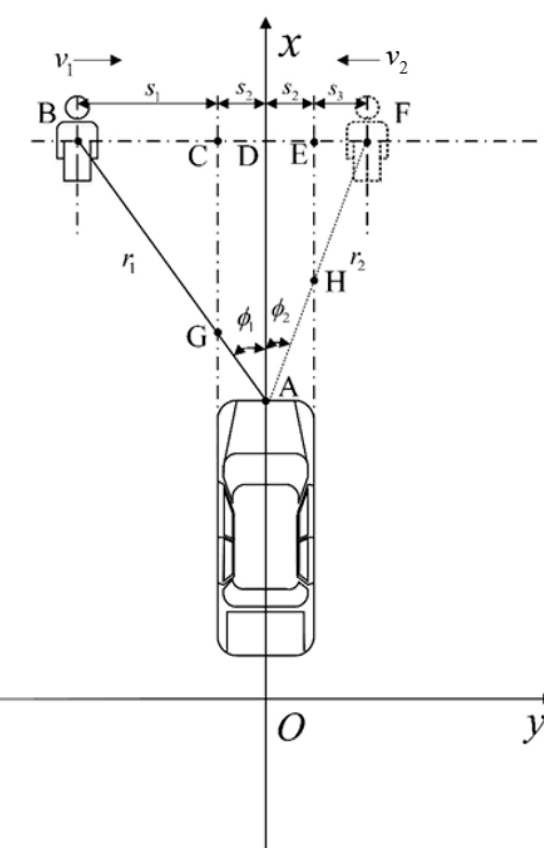
Figure 8. Working area division of the AEB ‐ P system.